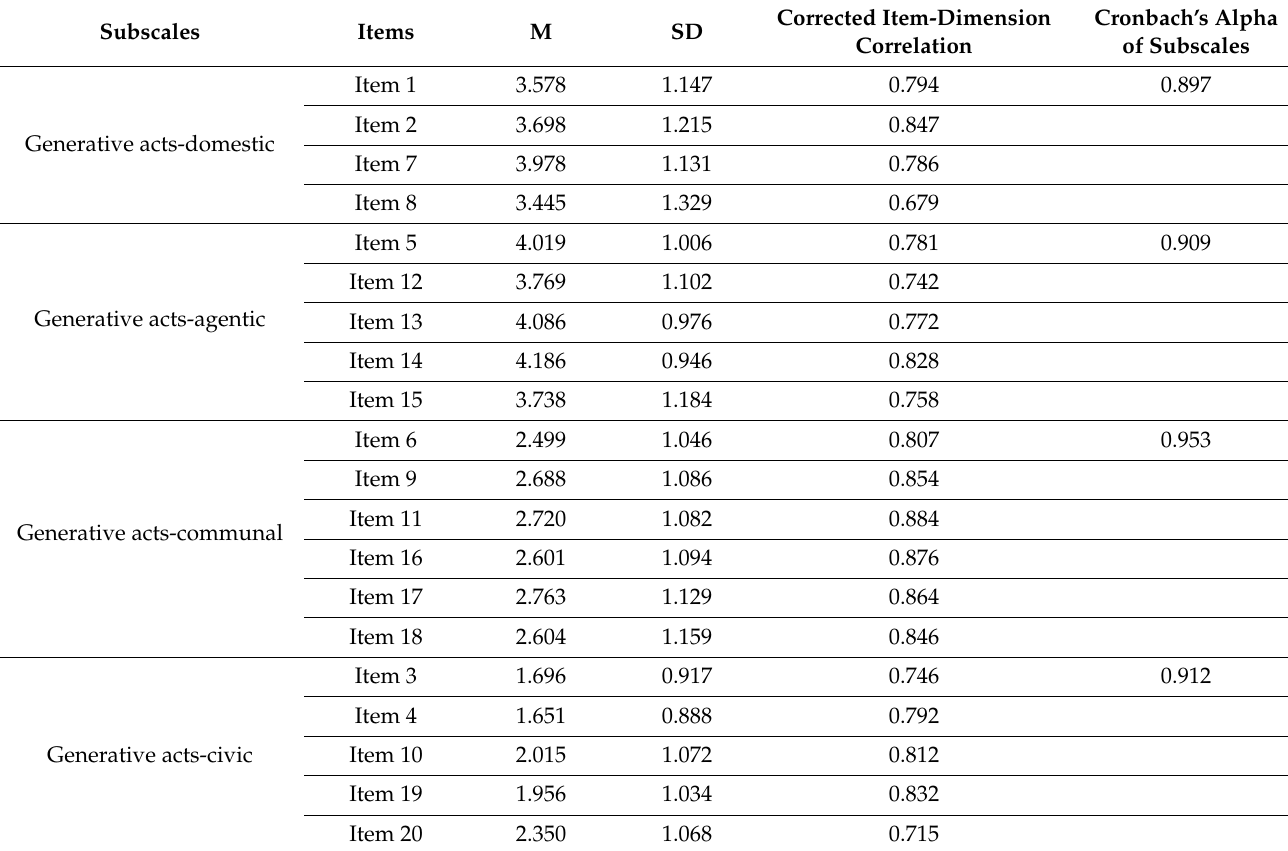
Table 4. Description and reliability estimation of the GAS-C items and